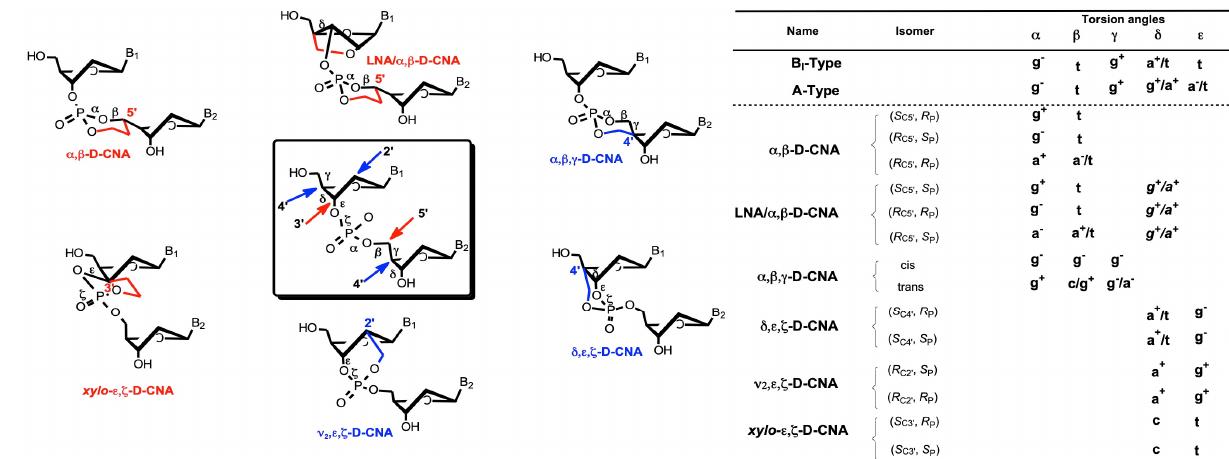
Figure 6. D-CNA family and determined torsional angles.